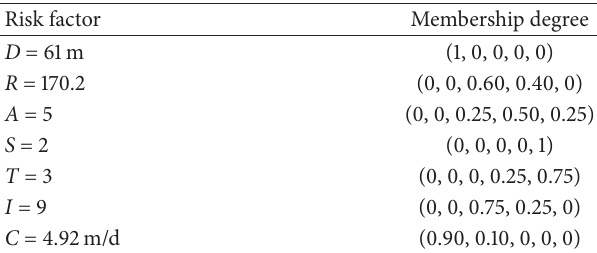
Table 10: Membership degrees of the factors in sample